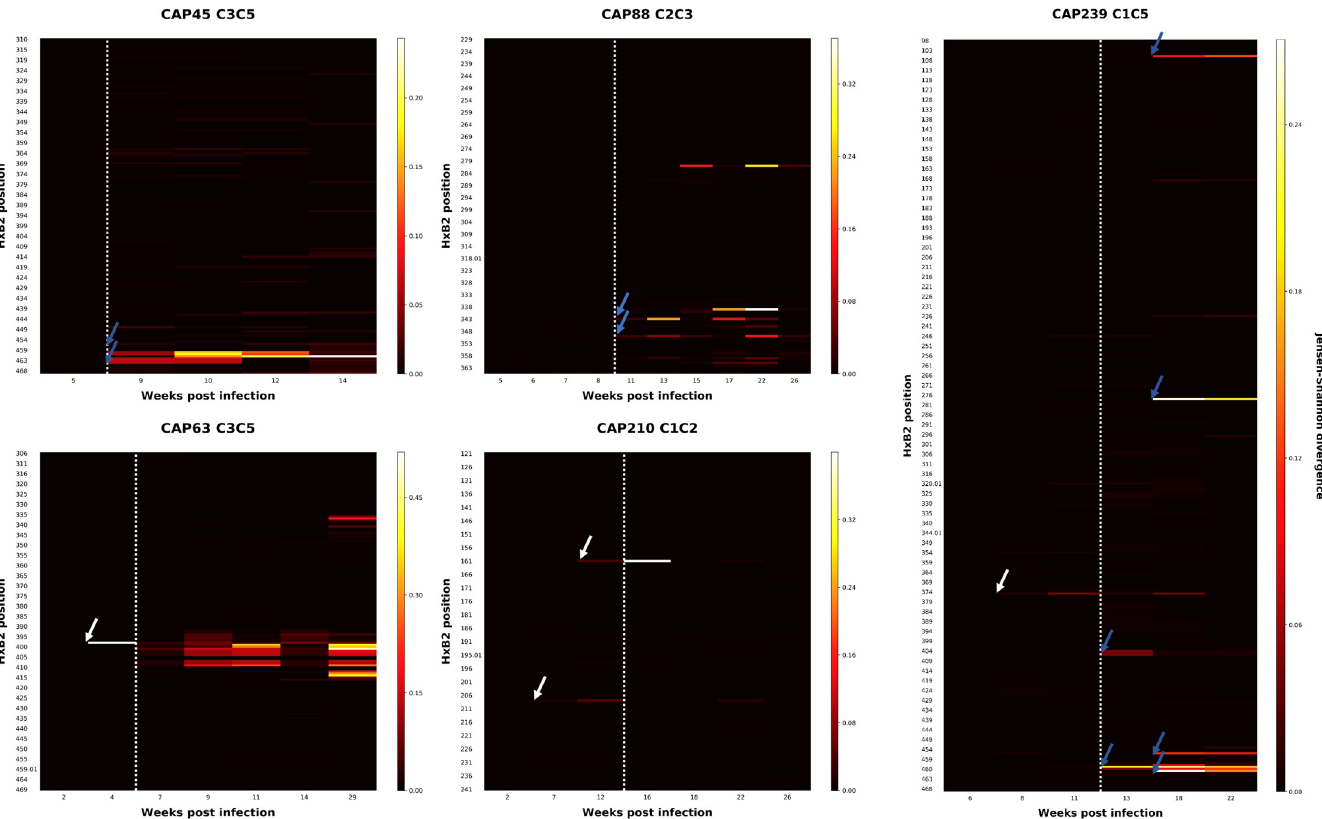
Fig 7. Jensen-Shannon Divergence (D JS ) plots of the region targeted by initial autologous nAb responses in five CAPRISA 002 participants. D JS for each position at each time-point sequenced was calculated. White arrows indicate sites exhibiting high D JS prior to detectable nAbs: one site (position 397) in CAP63, two sites (161 and 208) in CAP210, and one site in CAP239 (365). Sites exhibiting raised D JS after the detection of nAbs are identified using blue arrows: three sites (positions 460– 462) in CAP45, two sites (positions 343 and 350) in CAP88 and five sites (106, 278, 459, 463 and 463.02) in CAP239, which were identified as a second wave of sites which diverged later (blue arrows). The white dotted line indicates the time from which the initial autologous antibody response was first detected (Titers > 1:50).